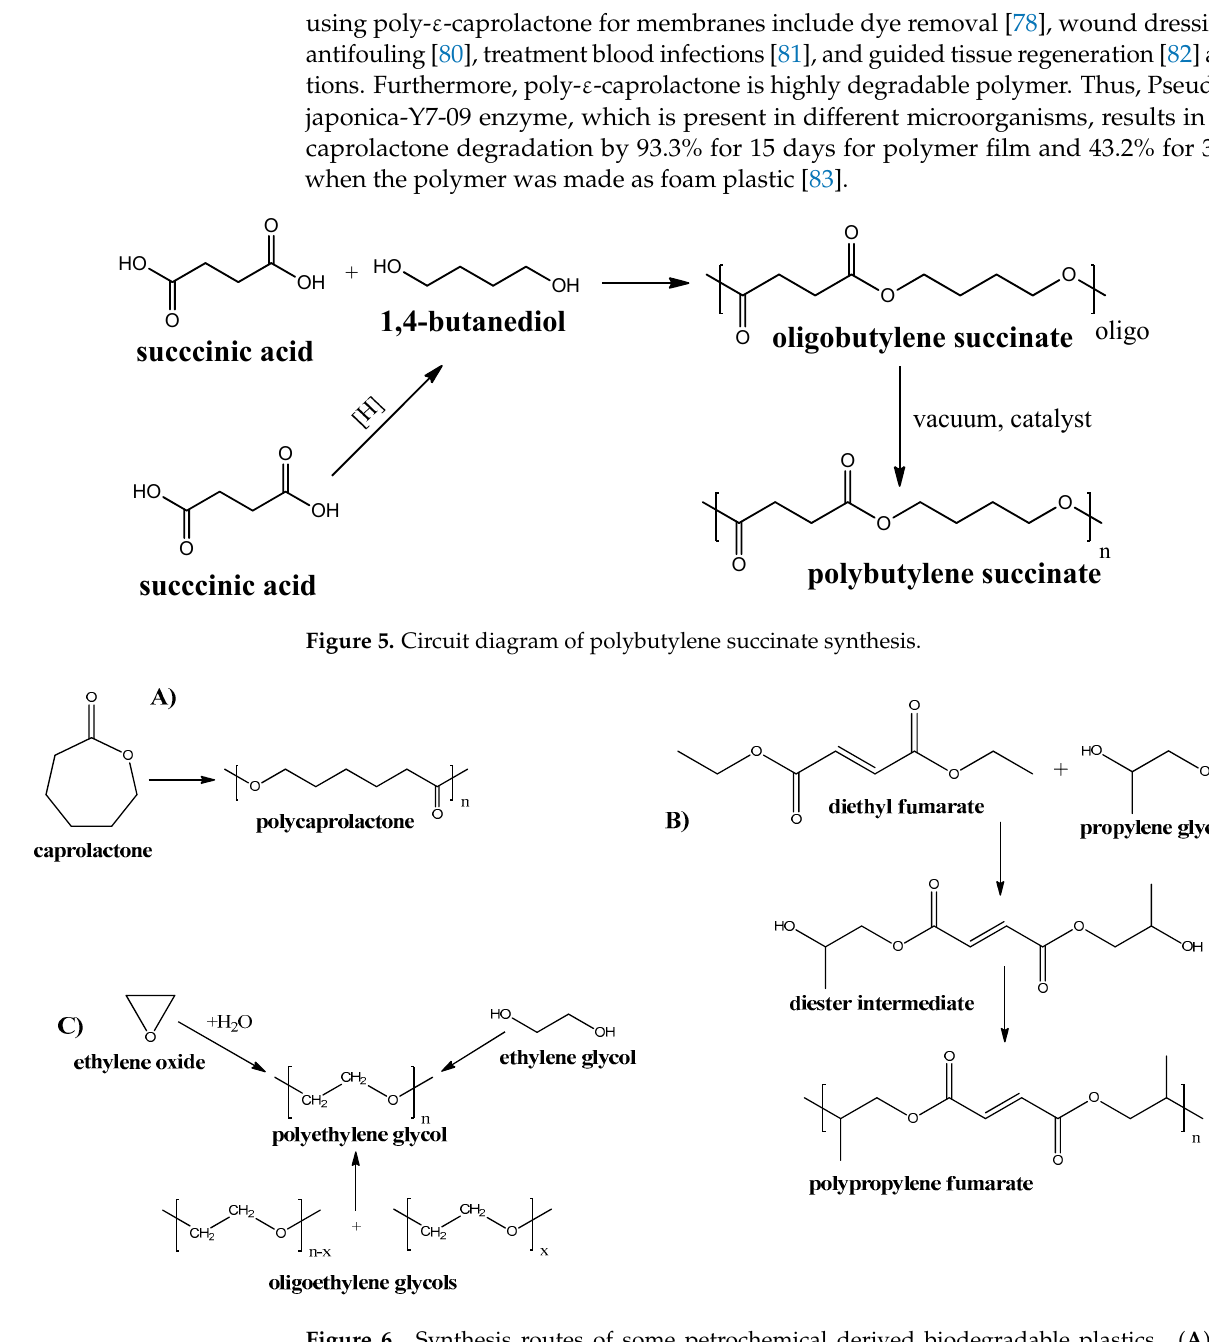
Figure 7. Polyvinyl alcohol synthesis from polyvinyl acetate hydrolysis. PVA has been reported to use for membrane preparation for wound dressing appli- cations [99,100]. In addition, PVA is biodegradable in the presence of different microor- ganisms under two-step metabolic processes, including oxidation and hydrolysis [101]. Polyurethane and Polyurethane Urea Polyurethanes (PU) are one of the most produced polymers in the world. Around 25 million tons of this class of polymer was produced in 2019, which is about of 6% of all manufactured polymers [102]. The interest to polyurethanes is determined by the broad chemical variety of monomer units, resulting in a wide range of physical properties–from rigid and strong plastics to flexible elastomers [103]. Linear PU are basically produced during polycondensation reaction between diisocyanates and diols (see Figure 8A, step 2A) with the ability to produce polyurethane urea when a diamine chain extender is used on the second synthesis step (see Figure 8A, step 2B).